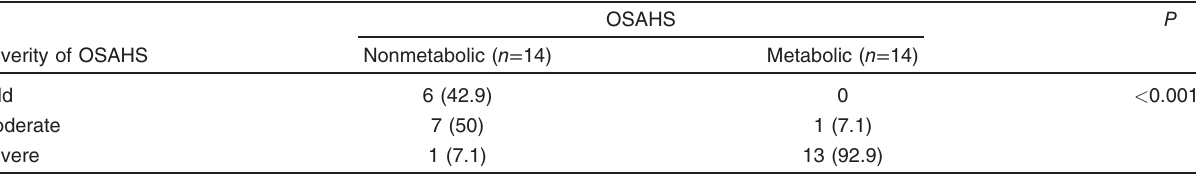
Table 4 Comparison between the two studied groups according to severity of obstructive sleep apnea hypopnea